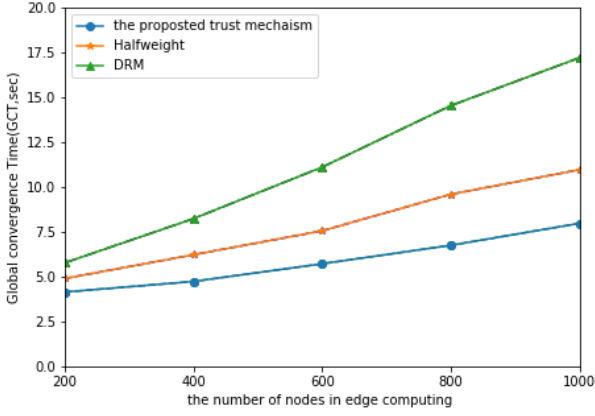
Figure 5. The proportion of MNs is 40% and that of PCN is